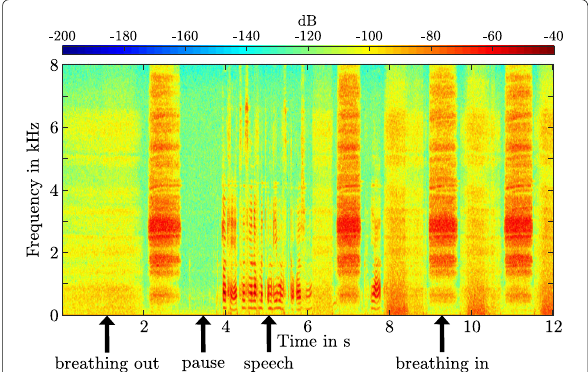
Fig. 9 Spectrogram of a microphone signal picked up by the masks communication